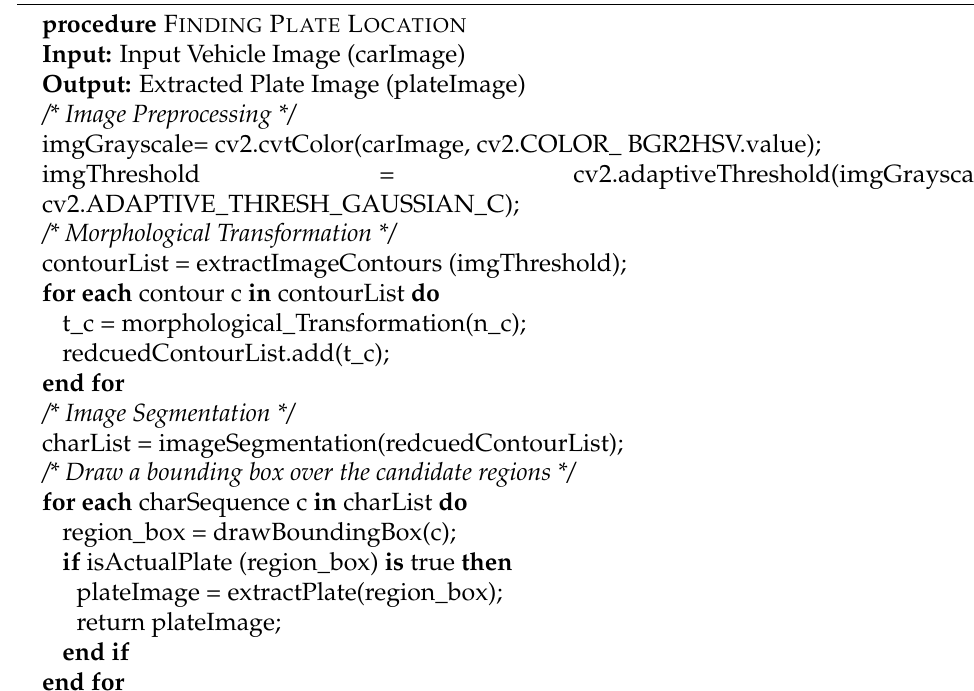
Algorithm 1 Plate Detection